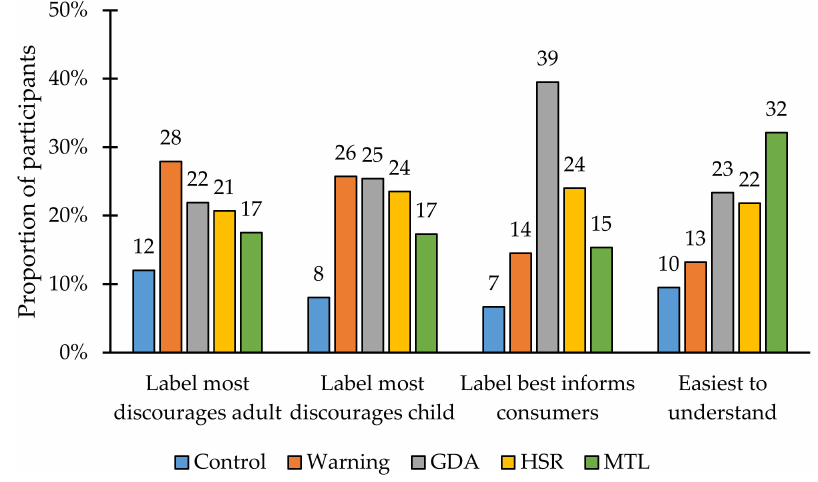
Figure 4. Percent of participants selecting a particular